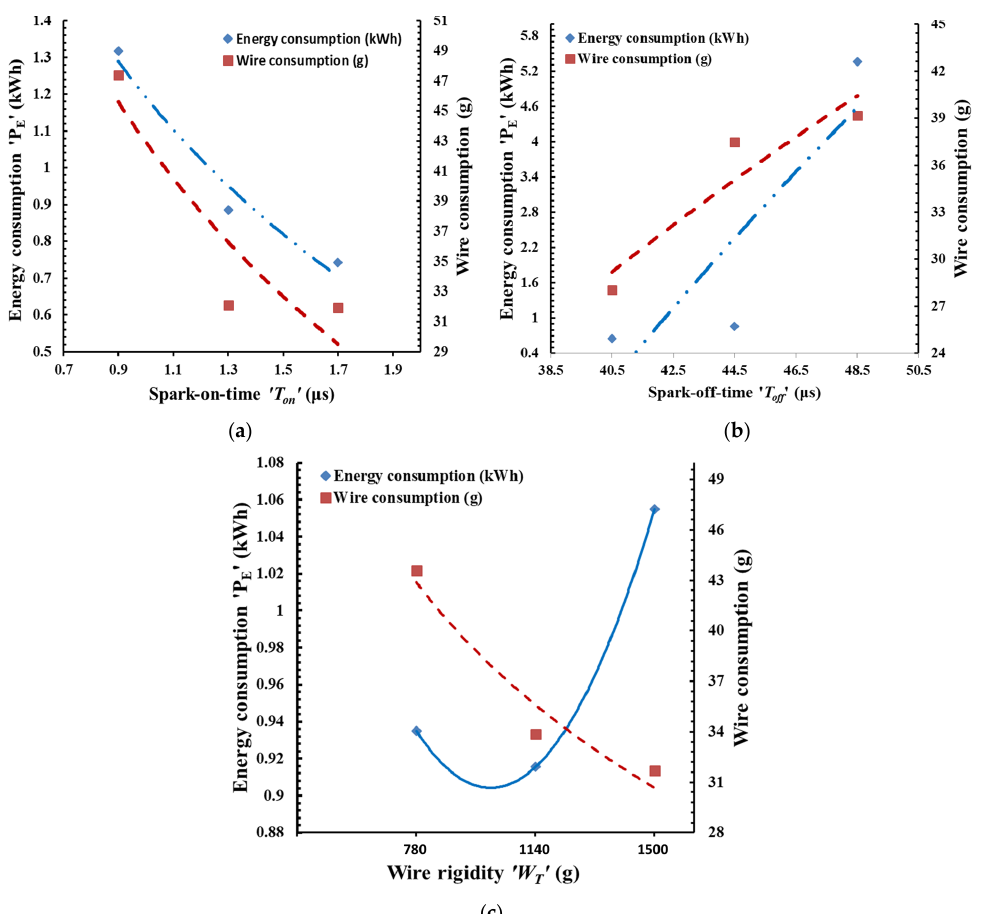
Figure 8. Variation of sustainability indicators with ( a ) spark-on-time; ( b ) spark-off-time; ( c ) wire rigidity. It is evident from Figure 8c that wire consumption decreases with an increase in wire rigidity, whereas energy consumption decreases to an optimum value and then in-